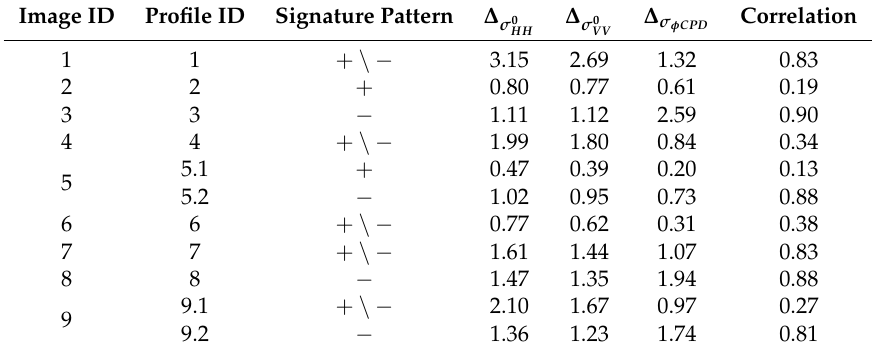
Table 2. General view of the IW signature patterns and associated parameters. The double sign and single-negative and -positive signatures are presented, respectively as + \ − , − , and + . Image ID Profile ID Signature Pattern ∆